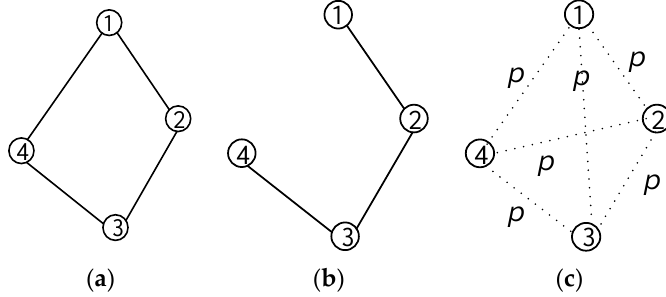
Figure 1. Different network models: ( a ) k nearest neighbor model; ( b ) disc model; and ( c ) Erdos-Renyi random graph.